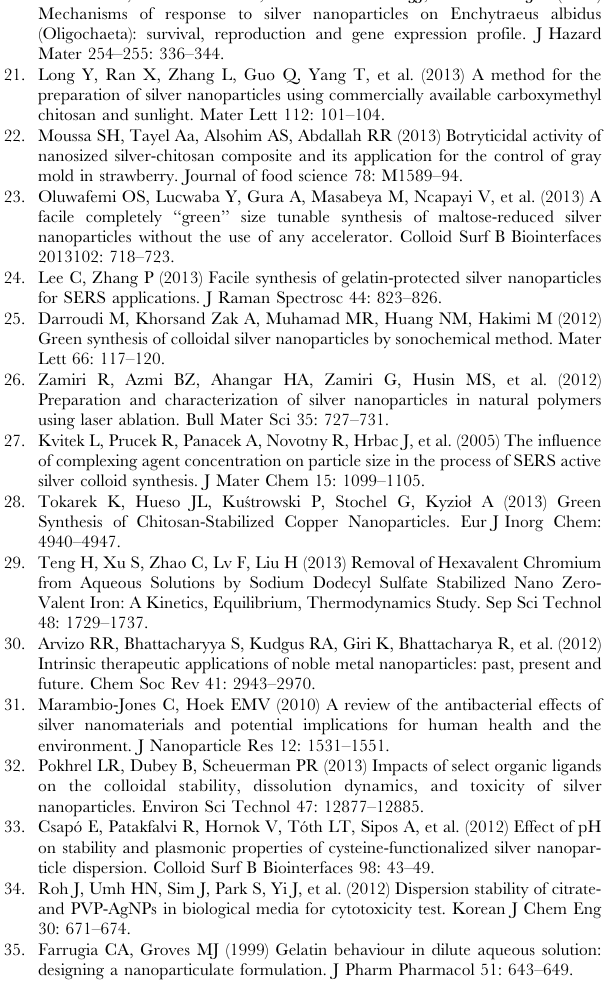
Figure S1 TEM images and corresponding particle size distribution histograms of AgNPs reduced by maltose in the presence of gelatin. The concentrations of gelatin were 0.00025 Figure S2 TEM images and corresponding particle size distribution histograms of AgNPs reduced by ascorbic acid in the presence of gelatin. The concentrations of gelatin were 0.025